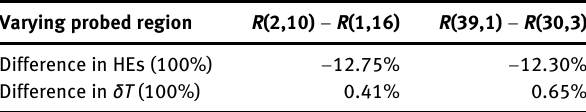
Table  : HE generation rate and temperature increase of groups  and  .